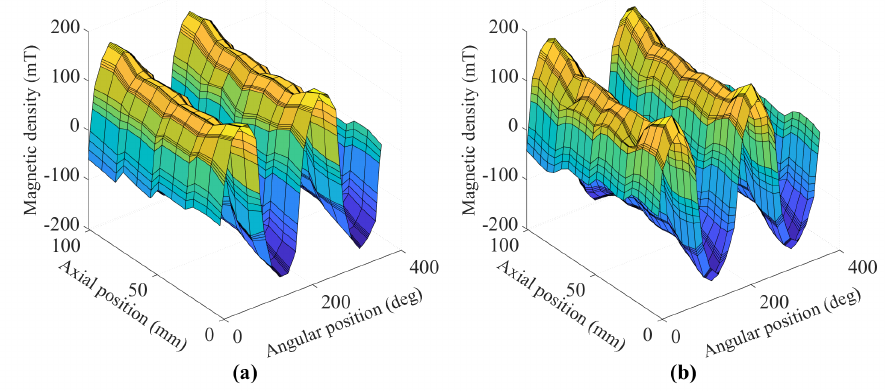
Figure 6. Side-by-side comparison of measured magnetic field strength of the permanent magnet rotor ( a ) before and ( b ) after the heat treatment.